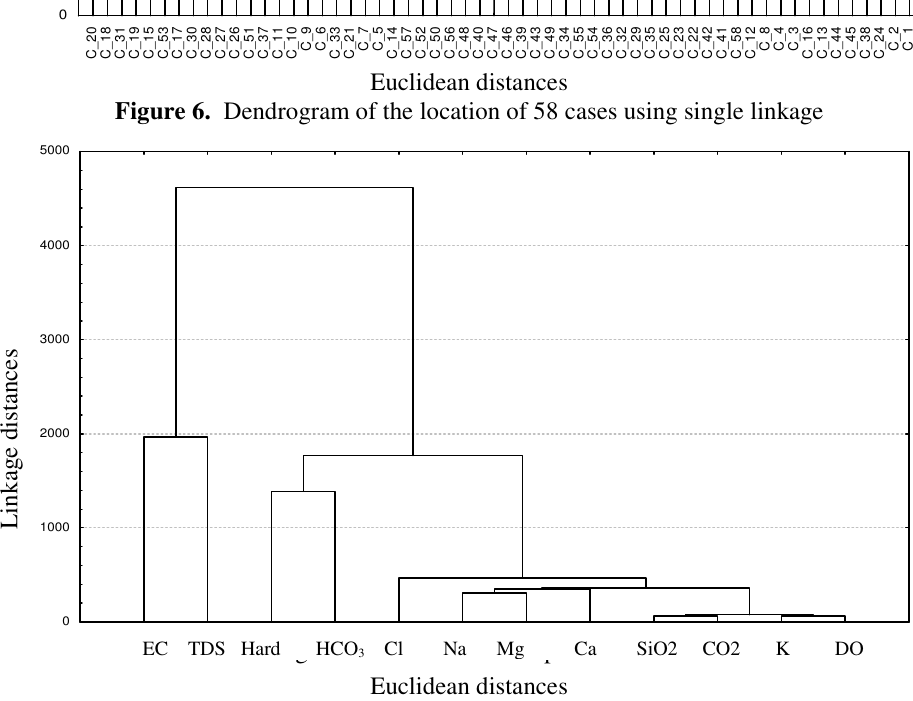
Figure 7. Dendrogram of the 12 chemical parameters of 58